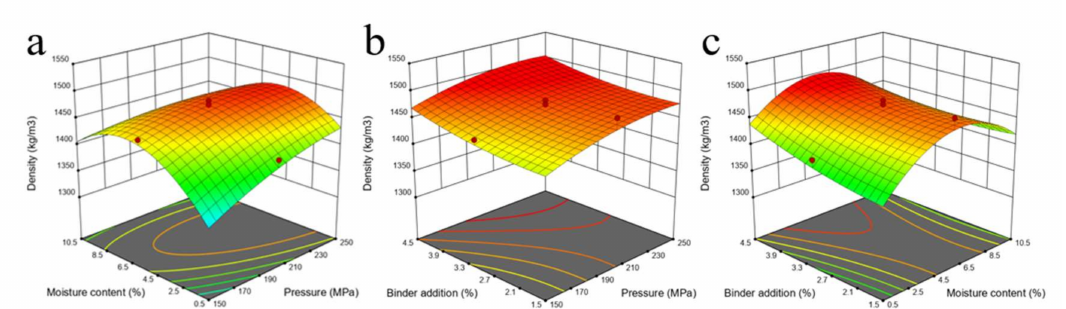
Figure 6. Three-dimensional surface plot and interactions of process variables on density. ( a ) Effect of pressure and moisture content at binder addition of 3%; ( b ) Effect of pressure and binder addition at moisture content of 5.5%; ( c ) Effect of moisture content and binder addition at pressure of 200